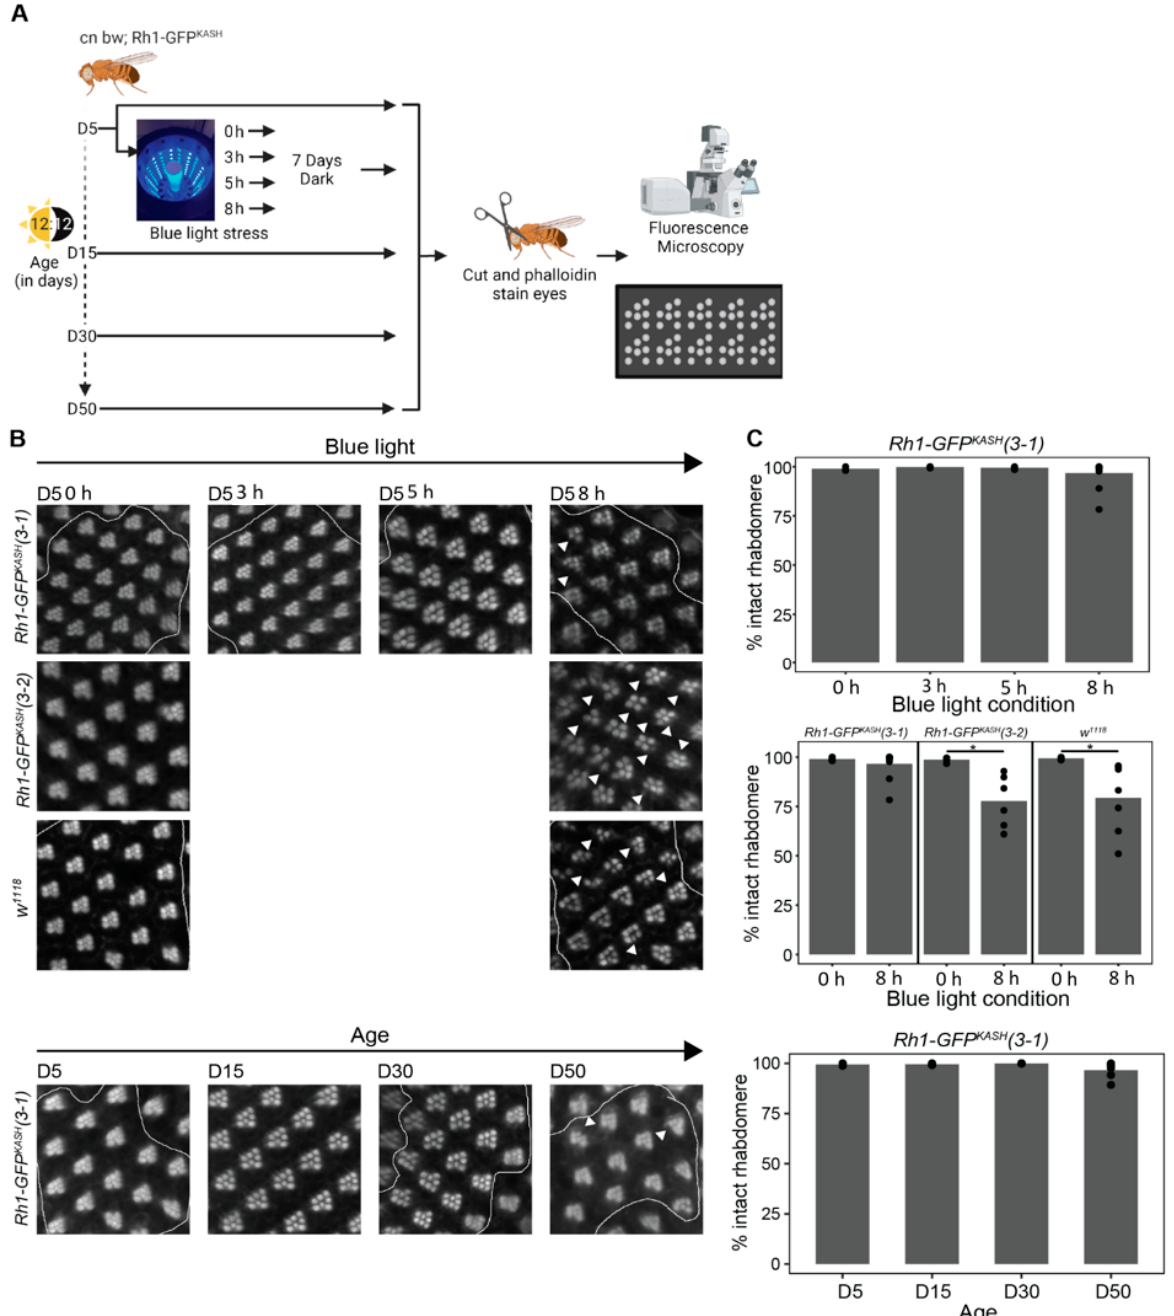
Figure 6. Catalase overexpression correlates with mild suppression of retinal degeneration in Rh1-GFP KASH (3–1) flies. ( A ) Overview of the experimental design for assessing retinal degeneration in male flies of the indicated genotypes at D5, D15, D30 and D50, or D5 flies exposed to 0, 3, 5 or 8 h of blue light. ( B ) Representative images of dissected and phalloidin (F-actin) stained blue light exposed or aged eyes from the indicated genotypes ( cn bw; Rh1-GFP KASH (3–1) , cn bw; Rh1-GFP KASH (3–2) or w 1118 ). Arrow heads point to ommatidia or regions in the eye with degenerated rhabdomeres. ( C ) Quantification (displayed as percent of intact rhabdomere) of rhabdomere loss in aged or blue light exposed flies from the indicated genotypes ( n ≥ 5). Black circles indicate individual biological replicates (flies), and mean shown by bar height. p -value (* <0.05), t -test.